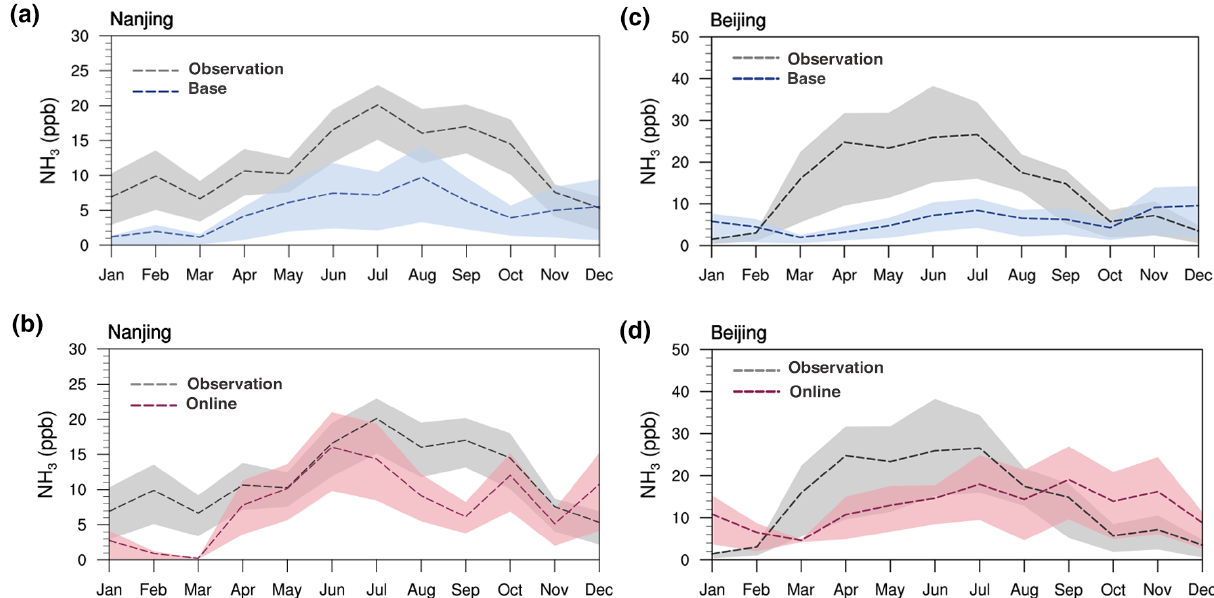
Figure 5. Monthly average ammonia concentrations at the 2019 Nanjing site for base (a) and online (b) model runs and measurements locally. The dashed lines indicate mean values. Lower and upper ends of the filled area indicate the 25th and 75th percentiles of each distribution. Panels (c) and (d) are in the Beijing